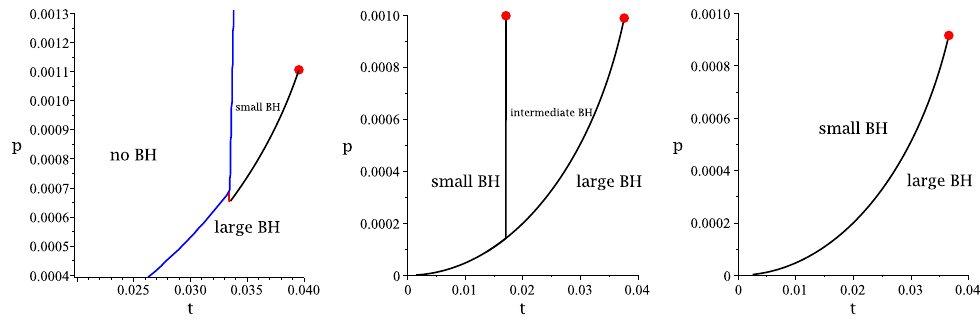
Figure 2 . Phase plots for k = 1 , (cid:15) = +1 and q = 0 : Left : plot for (cid:11) = 25 and h = 5. The black curve denotes the coexistence line which ends at the physical critical point (red point). The blue curve denotes the boundary of the \no black hole region" and the (small) red line denotes a zeroth-order phase transition. For pressures in this region, a large-small-large reentrant phase transition takes place. Center : plot for (cid:11) = 27 and h = 0 : 9899 showing a triple point where the three coexistence curves intersect. Right : plot for (cid:11) = 27 and h = (cid:0) 11 showing a single physical critical point and coexistence curve displaying van der Waals type